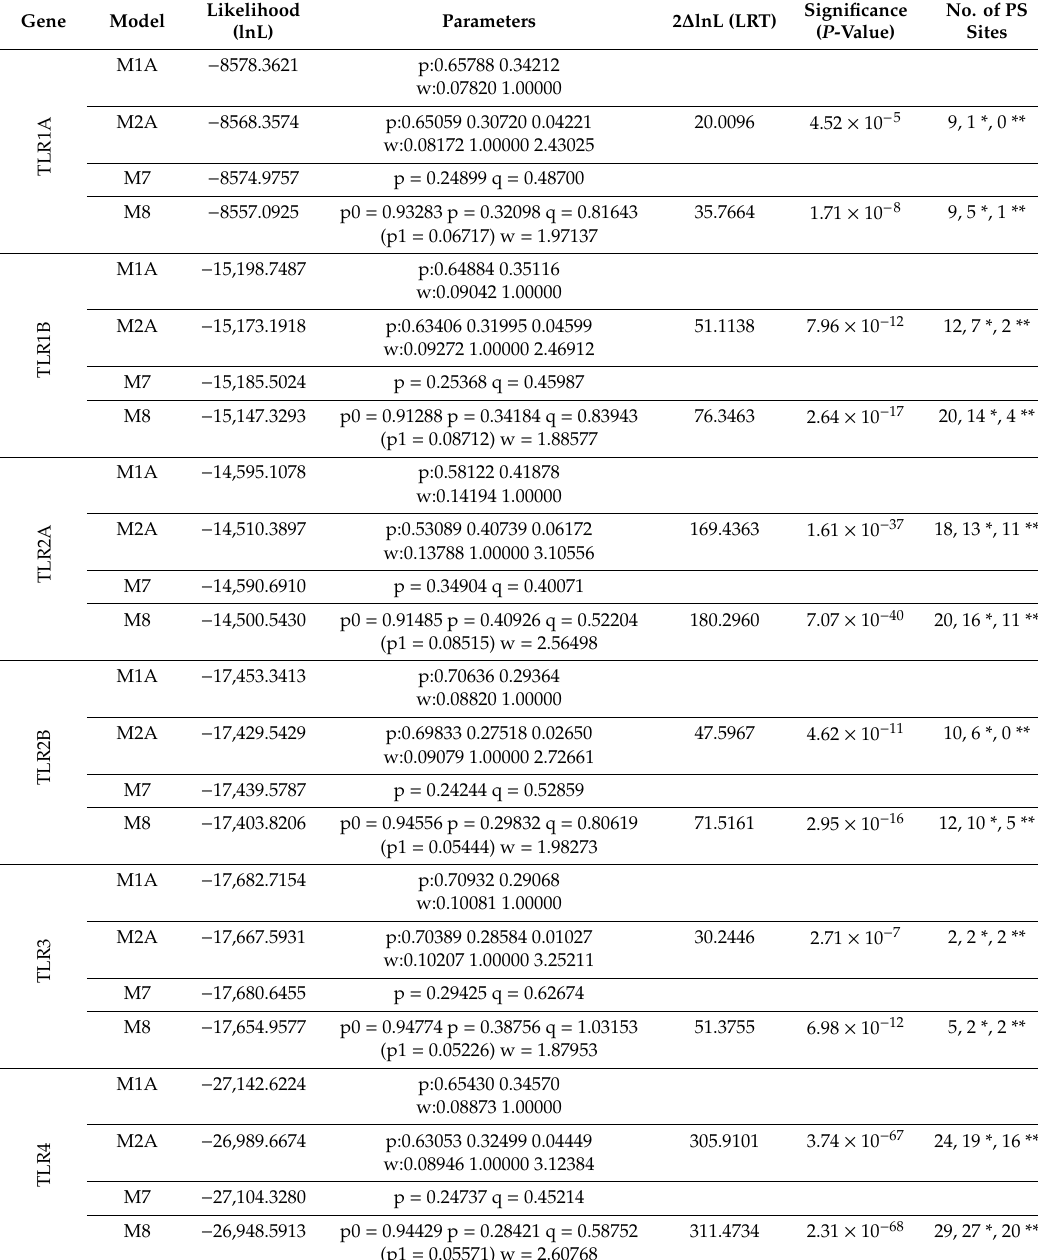
Table 2. PAML results for nested site model comparisons for test of positive